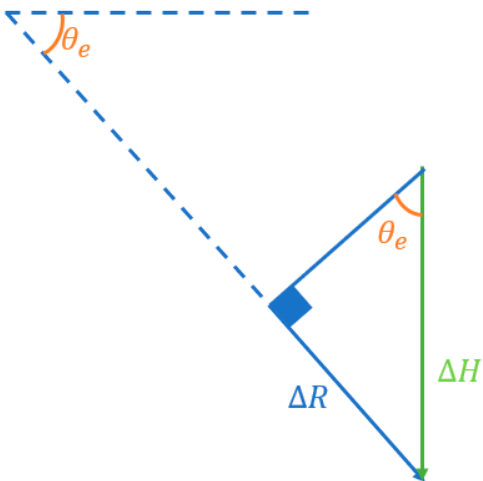
Figure 3. Interaction between radar signal and crop height.